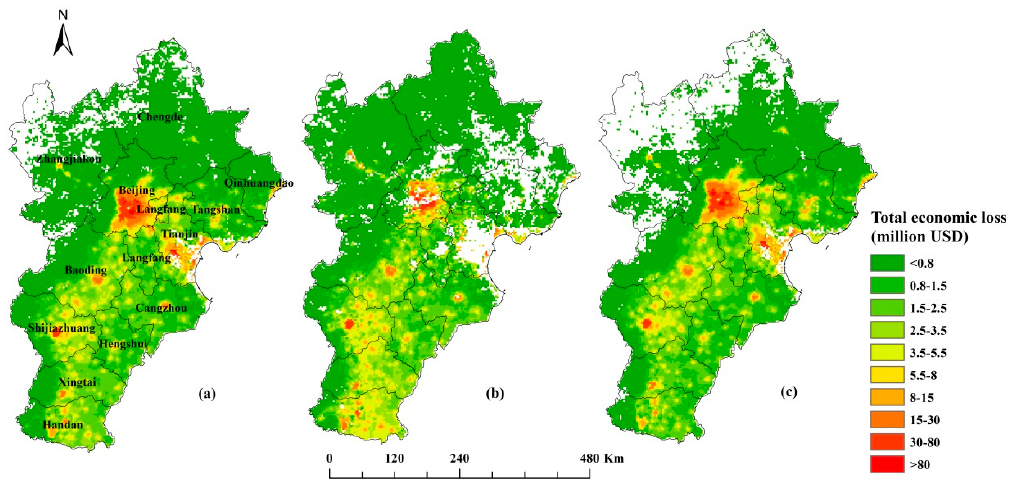
Figure 6. Spatial distribution of the total economic costs associated with PM 2.5 in ( a ) 2016, and in ( b ) the cold season and ( c ) the warm season in